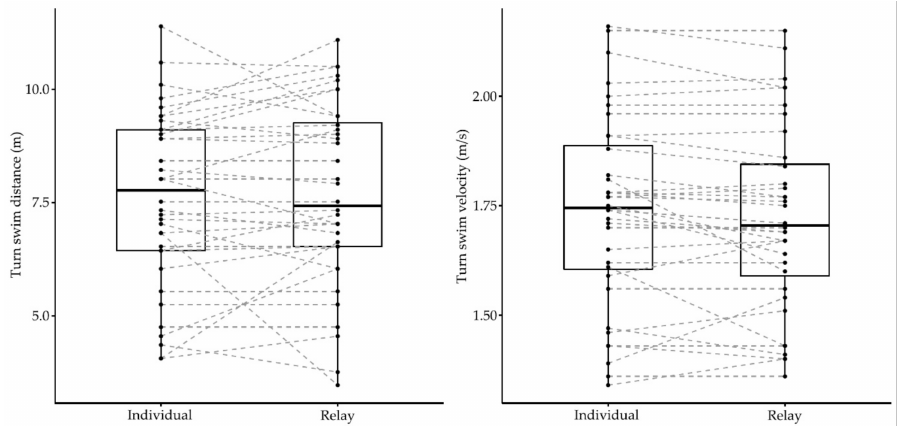
Figure 5. Individual and group variation in the swim turn phase between individual and relay events of the LEN European Junior Swimming